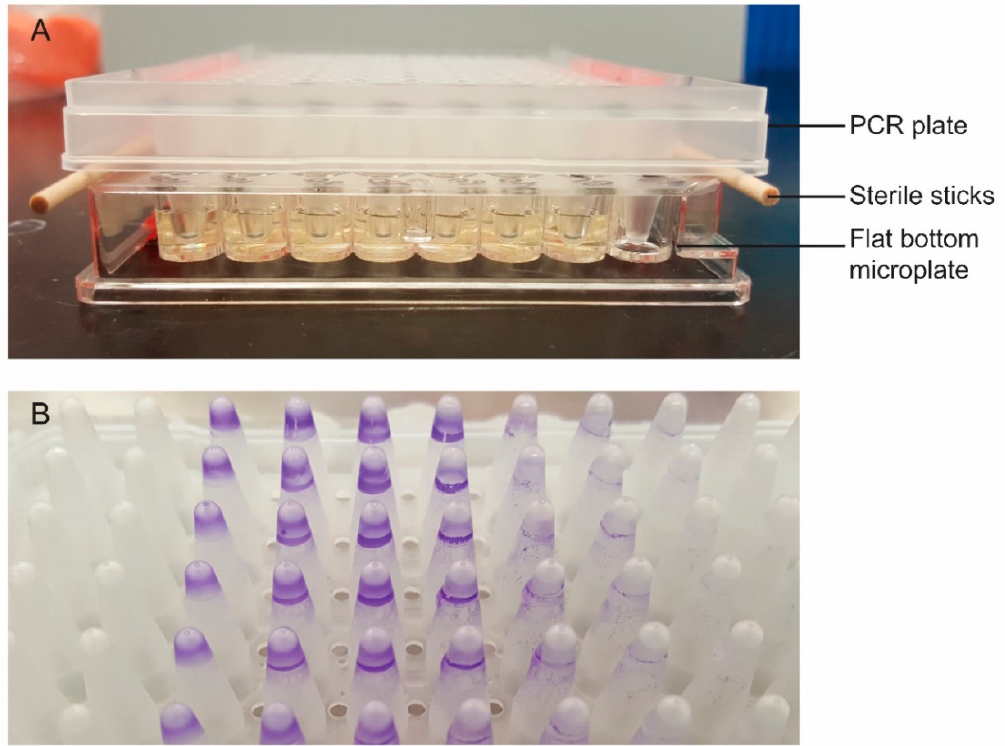
Figure 1. Two-component apparatus for detecting biofilm formation ( A ). The pegs of the PCR plate are submerged into wells of the flat bottom microplate containing bacterial cells. The PCR plate rests on top of 2 sterile sticks to prevent the pegs from direct contact with the bottom of the microplate. Biofilms form on the pegs that are subsequently stained with 1% crystal violet ( B ).